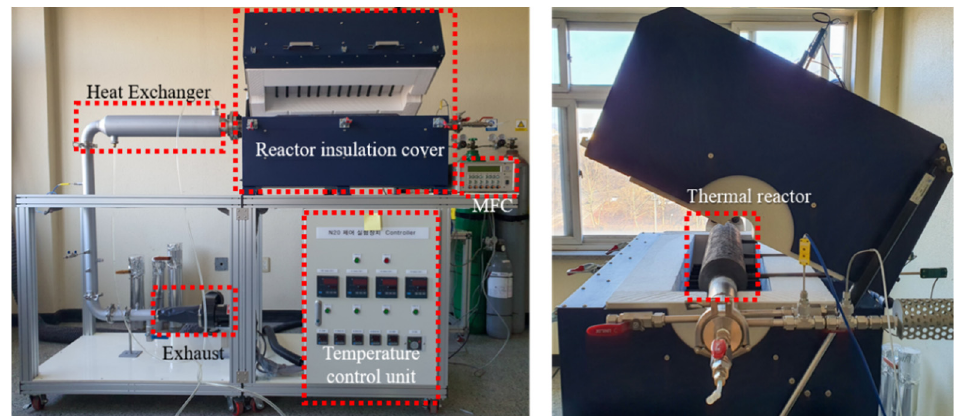
Figure 3. The laboratory scale selective non-catalytic reaction (SNCR) system.